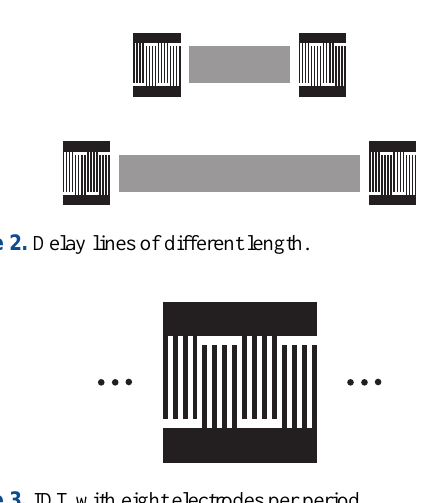
Figure 3. IDT with eight electrodes per period.